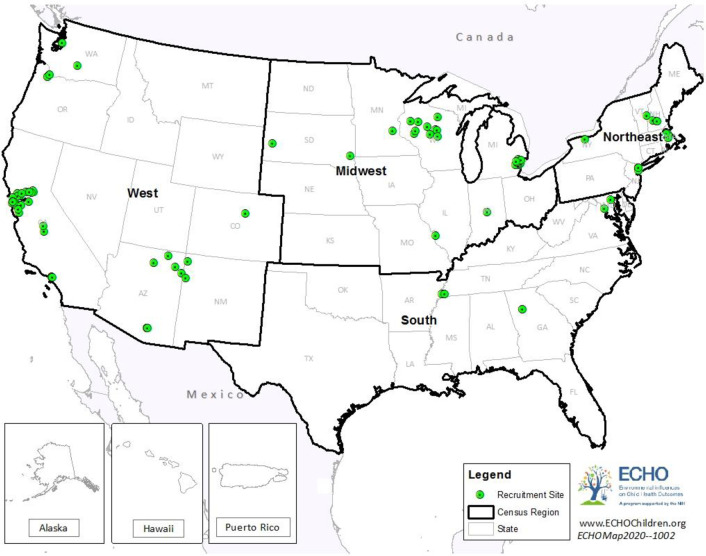
Cohort recruitment sites (n = 110) by US census region.